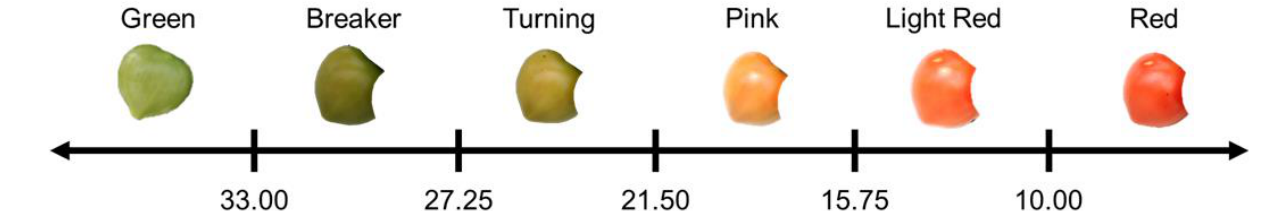
Figure 10. The relationship between hue color model and maturity level for the tomato fruits.